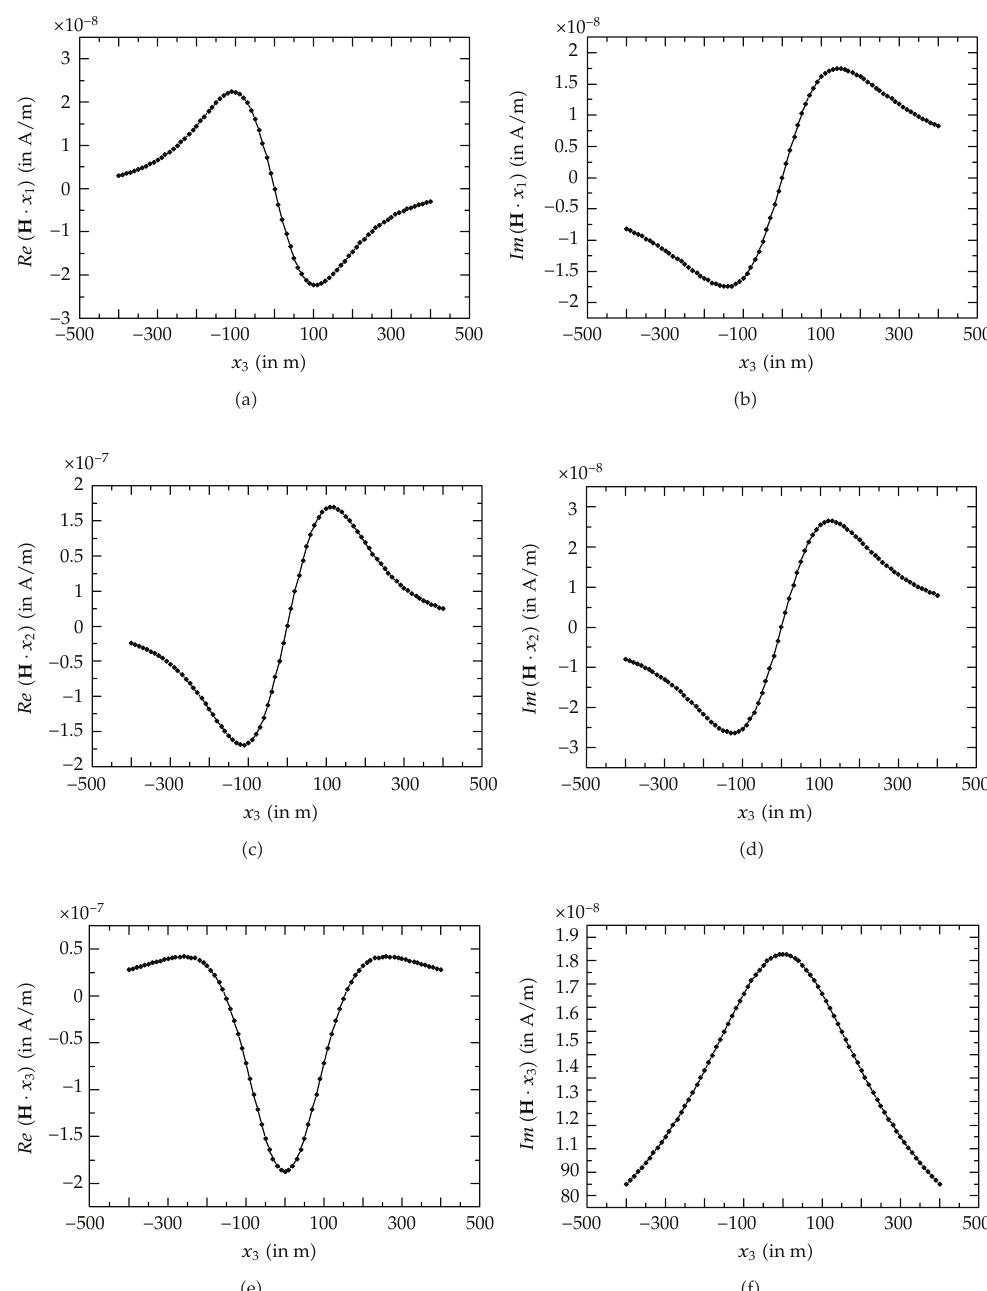
Figure 2: The real and the imaginary parts of the approximated low-frequency scattered magnetic field H for the orders n (cid:4) 0 , 2 , 3. The two spheres have equal radii α 1 (cid:4) α 2 (cid:4) 25m and their centers are at d (cid:4) 75m. The magnetic dipole is located at (cid:2) x 10 ,x 20 ,x 30 (cid:3) (cid:4) (cid:2) 200m , 0m , 0m (cid:3) and the measurement line probe is placed at (cid:2) x 1 p ,x 2 p ,x 3 p (cid:3) (cid:4) (cid:2) 0m , 200m , (cid:6) − 400 , 400 (cid:7) m (cid:3) , obtaining the field on the x 3